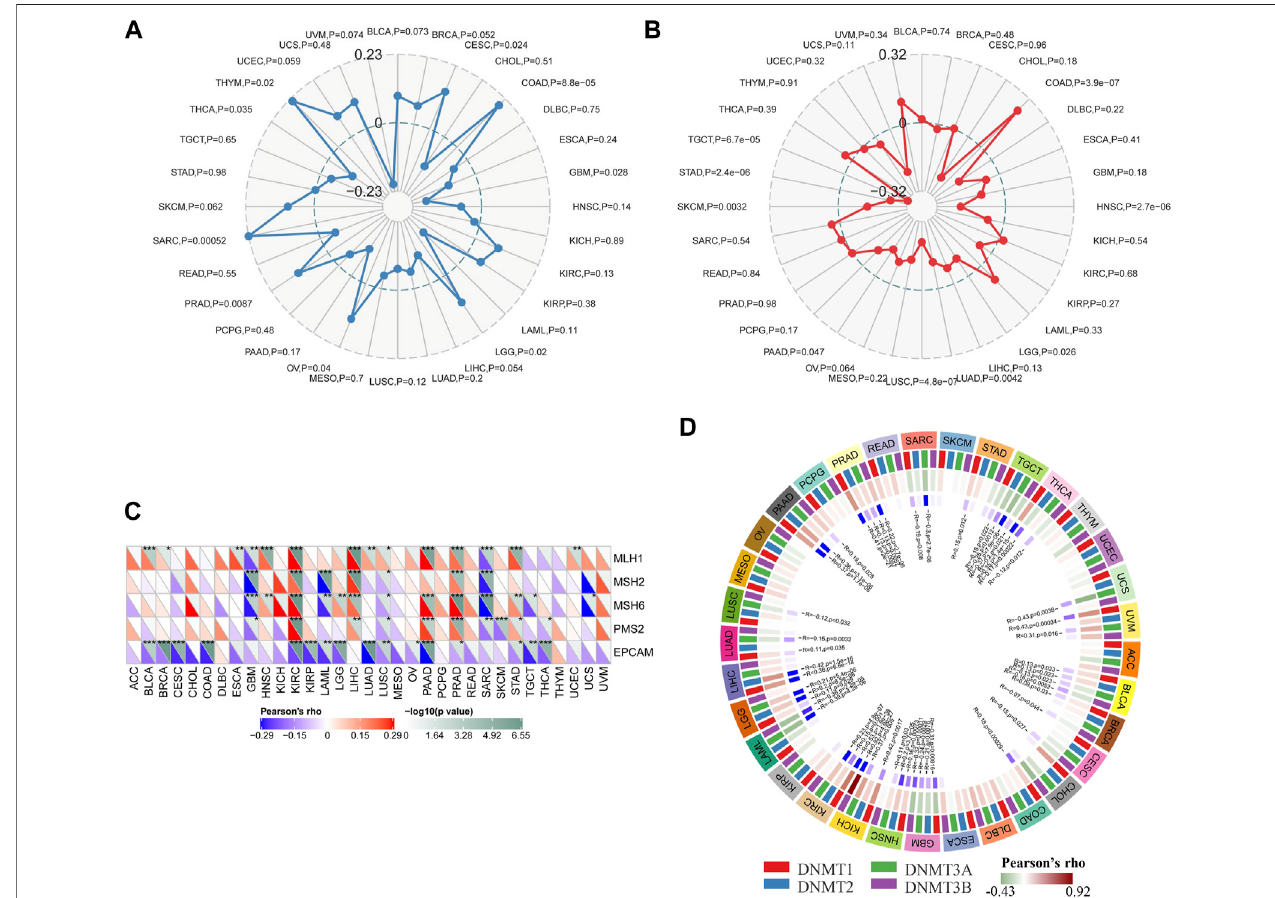
FIGURE7| CorrelationbetweenSiglec-9mRNAexpressionandtumormutationburden(TMB),microsatelliteinstability(MSI),DNAmethyltransferase(DNMT),and mismatch repair (MMR) in pan-cancer. (A) Relationship between Siglec-9 expression and TMB. (B) Relationship between Siglec-9 expression and MSI. (C) Correlation between Siglec-9 expression and MMR. (D) Correlation between Siglec-9 expression and DNMT (DNMT1 was red, DNMT2 was blue, DNMT3 was green, DNMT4 was purple). (Pearson ’ s correlation, p < 0.05 was considered signi fi cant, * p < 0.05, ** p < 0.01, *** p < 0.001.)